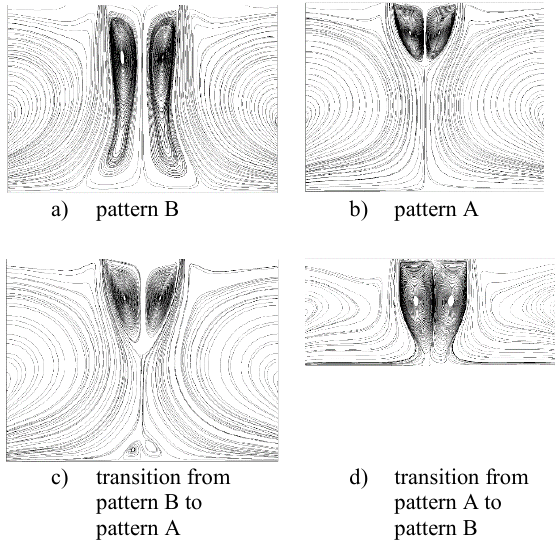
Fig. 2. Hysteresis loops of stagnation pressure at the intersection of jet axis with target